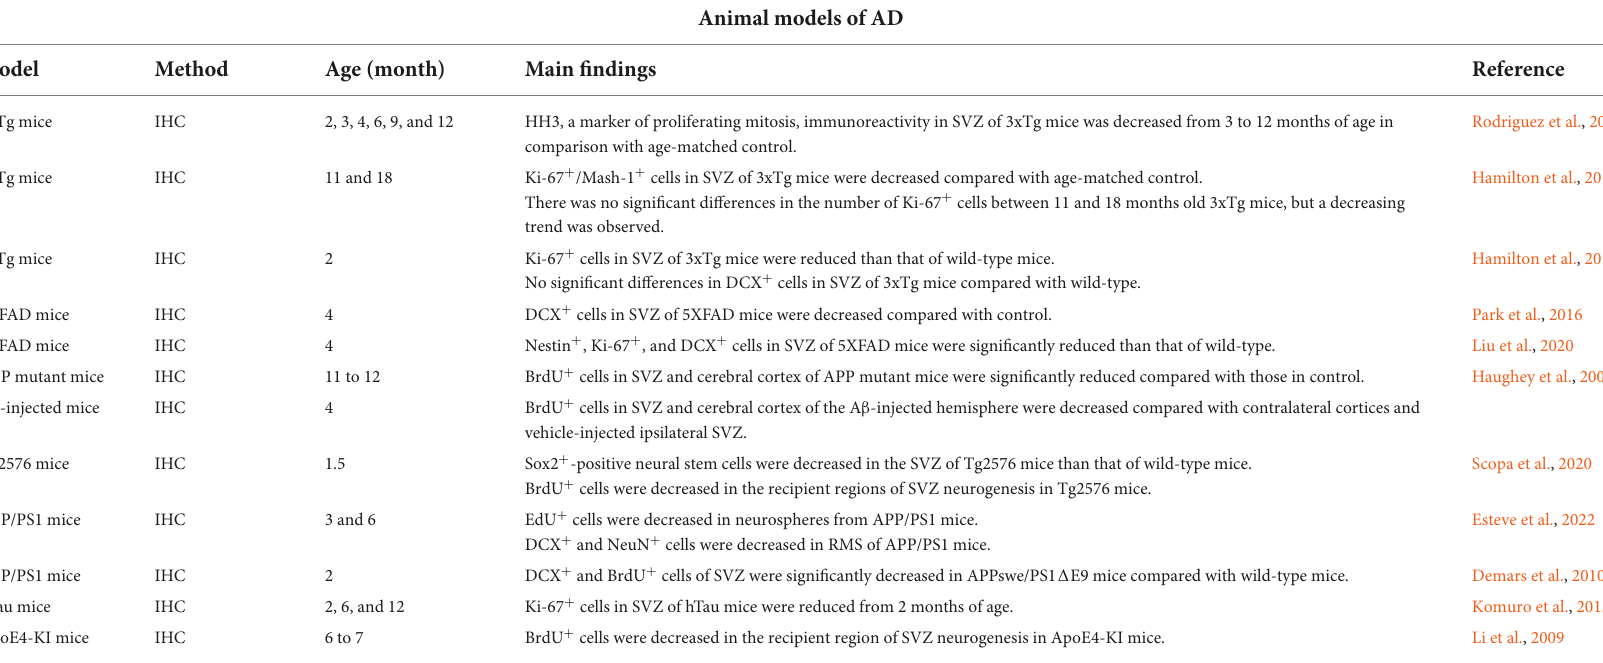
TABLE 1 Alteration of adult subventricular zone neurogenesis in Alzheimer’s